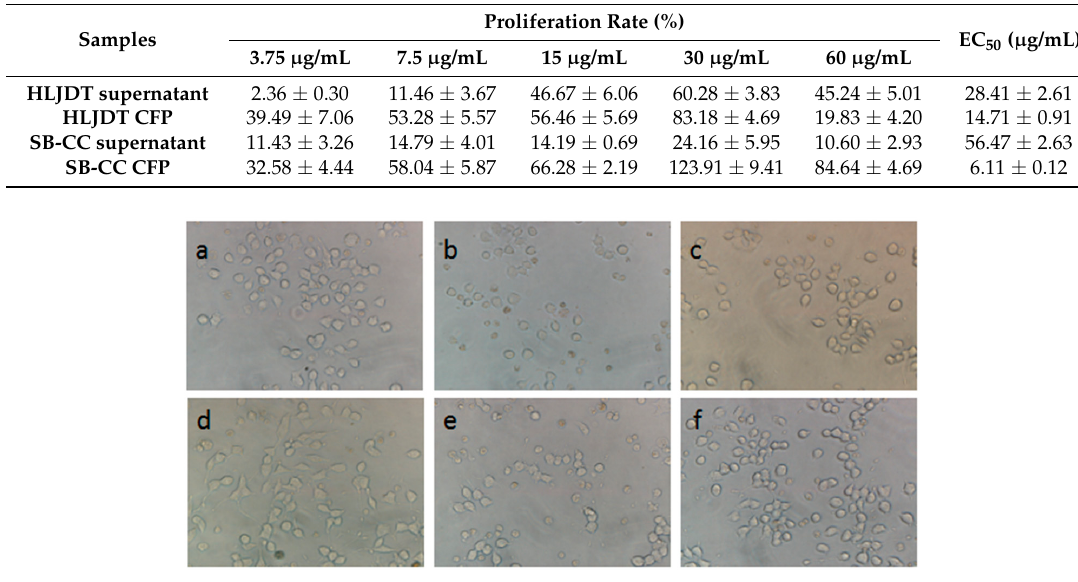
Figure 5. Morphological changes of PC12 cells under a light microscope. ( a ) Control group; ( b ) Model group; ( c ) Pretreatment with 30 µg/mL of HLJDT supernatant then injured by CoCl 2 ; ( d ) Pretreatment with 30 µg/mL of HLJDT CFP then injured by CoCl 2 ; ( e ) Pretreatment with 30 µg/mL of SB-CC supernatant then injured by CoCl 2 and ( f ) Pretreatment with 30 µg/mL of SB-CC CFP then injured by CoCl 2 (×400).